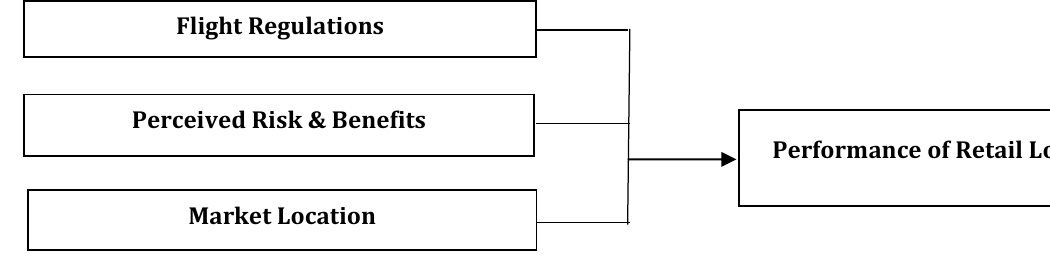
Performance of Retail Logistics